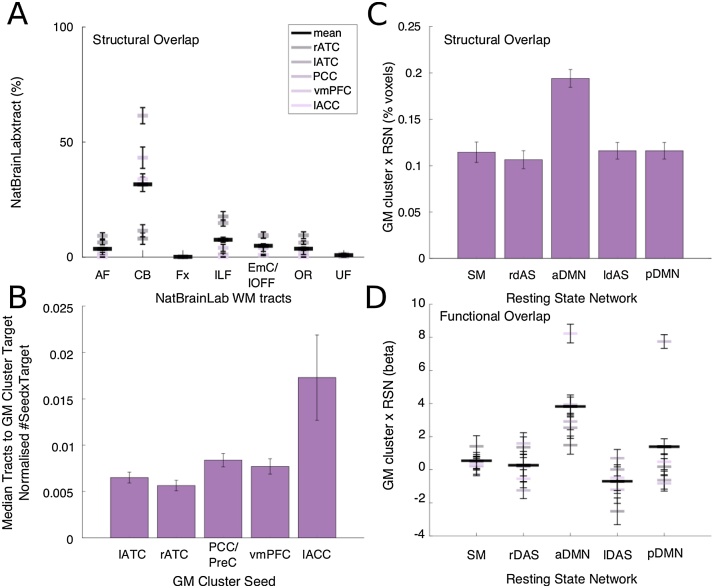
Network integration analyses. [A] Mean percentage overlap for each GM cluster seeded tractograms (grey-purple) and published WM tracts from the NatBrainLab. Black line plot shows mean percentage overlap over all three GM cluster seeded tractograms and between tractogram standard error. [B] Probabilistic tractography seeded in GM nodes with TBSS effects acting as waypoints and each non-seed defined as classification targets. Bar plot shows number of samples seeded from the GM cluster seeds reaching any target mask in the network. Subject’s median samples scores are normalised by the product of the size of the Seed and Target masks, then for each seed, averaged over targets and subjects [C] Mean percentage overlap between all GM clusters and each RSN. [D] Mean beta values expressing variance in the rsfMRI timeseries extracted from each GM cluster explained by each RSN timeseries. Black bars represents mean beta across the five GM clusters, and standard error averaged across GM clusters, for each RNS. Abbreviations: AF arcute fasciculus, CB cingulum bundle, Fx fornix, ILF inferior longitudinal fasciculus, EmC/lFOF extreme capsule / inferior fronto-occipital fasciculus, OR optic radiations, UF uncinate fasciculus, ATC anterior temporal cortex, PPC/PreC posterior parietal cortex / precuneus, ACC, anterior cingulate cortex, vmPFC ventromedial prefrontal cortex, SM sensory motor, dAS dorsal attention network, DMN default mode network. (For interpretation of the references to colour in this figure legend, the reader is referred to the web version of this article).